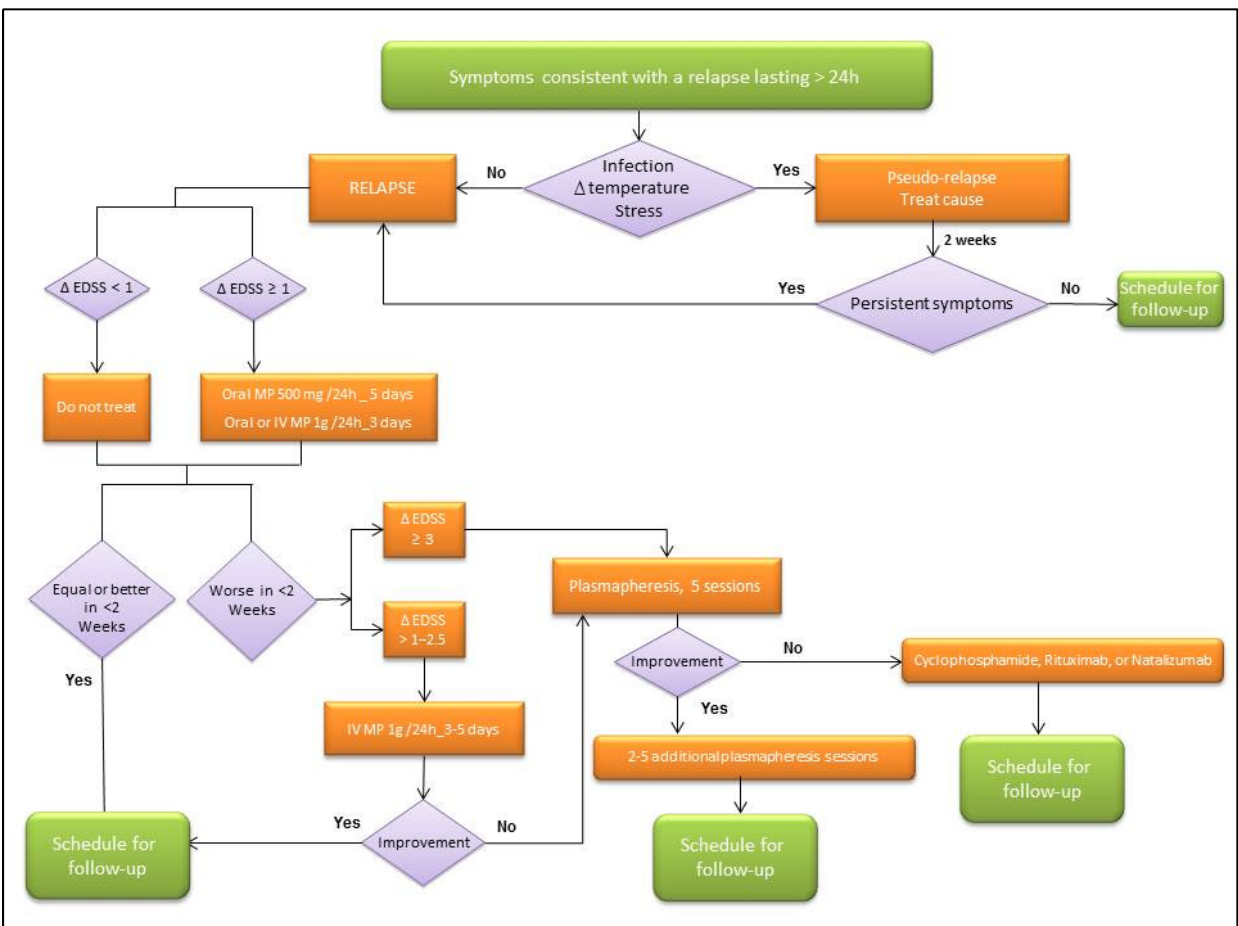
Figure 1. Therapeutic algorithm of MS relapse. Table 1. Recommendations for the Assessment of Patients with Suspected